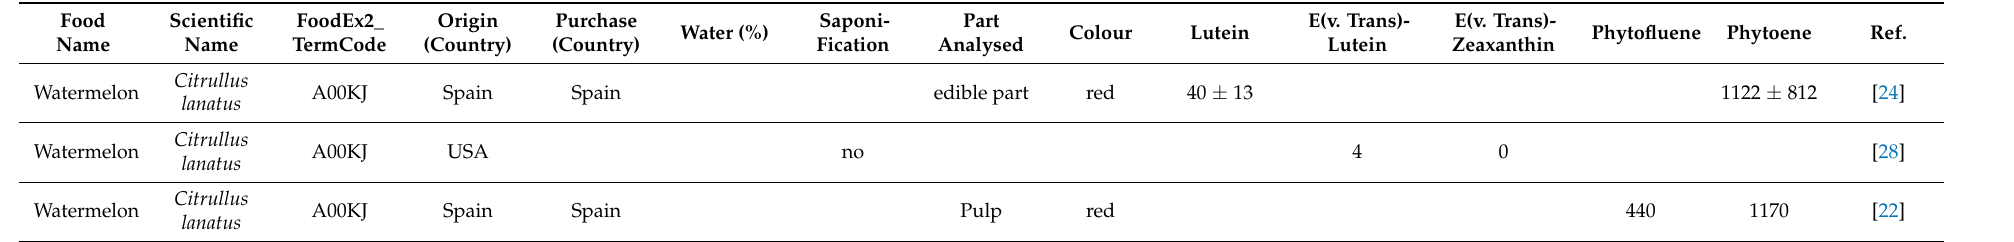
Table A9. Cucurbits with inedible peel (A00KD) ( µ g/100